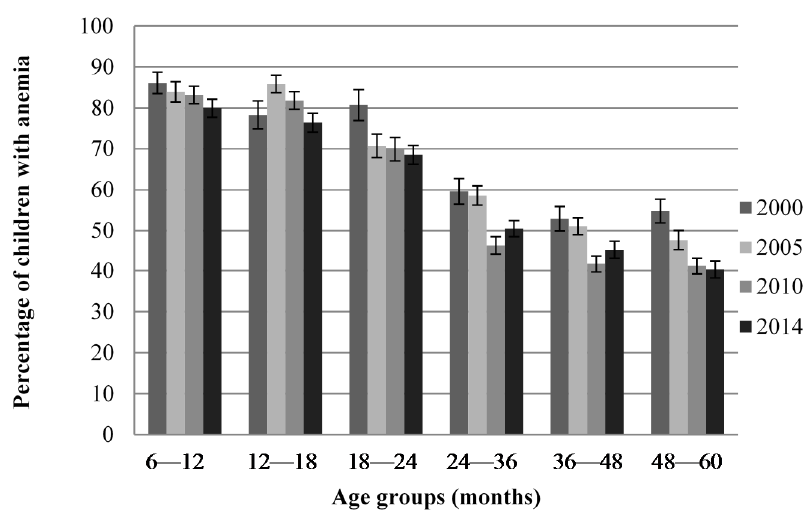
Figure 1. Percentage of children with anemia by age groups for each survey (% ± standard error).